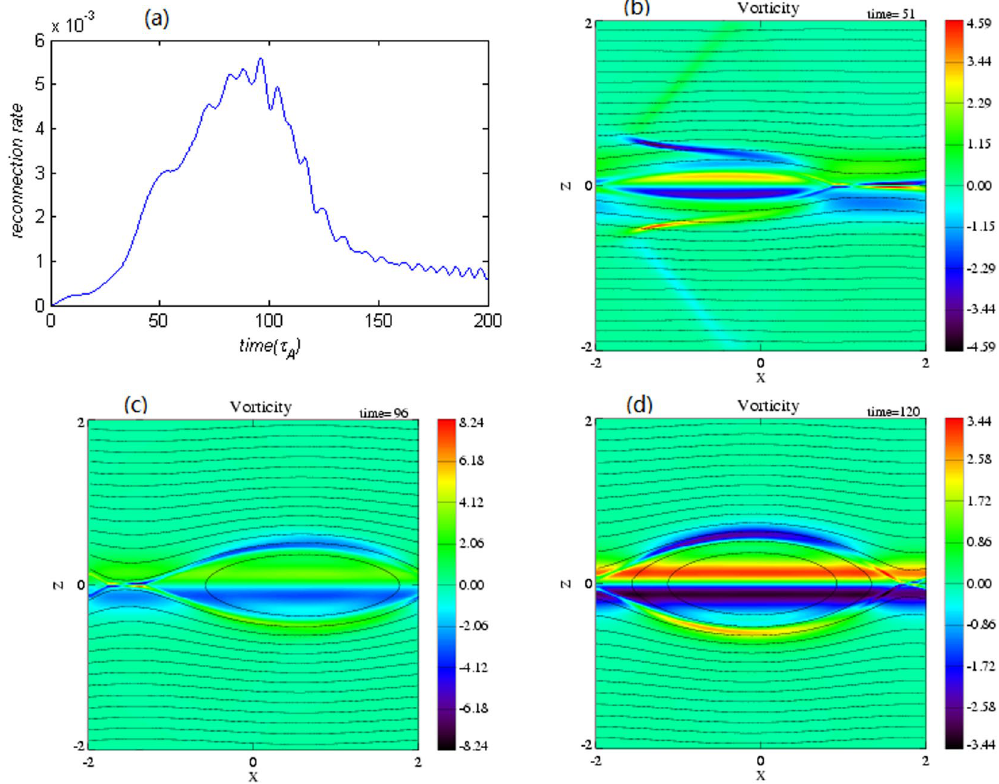
Figure 1. ( a ) Time evolution of reconnection rate for v 0 = 0.8 and the color contours ( b , c and d ) for distributions of the perturbed vorticity with magnetic field lines (black solid lines) at three different stages t = 51, 96,